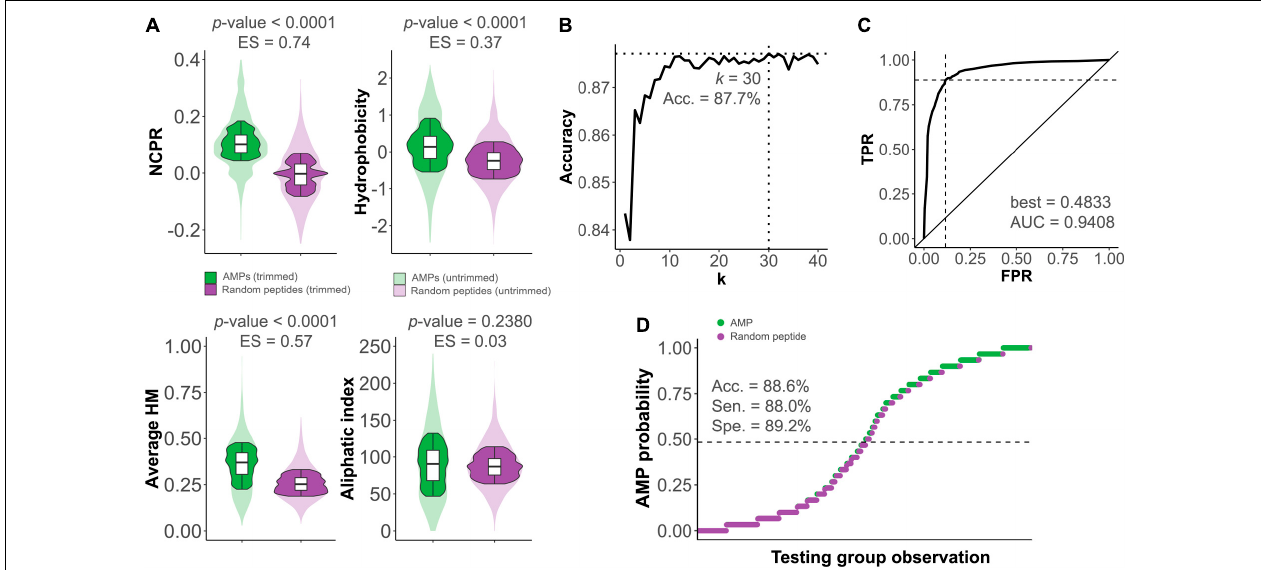
FIGURE 1 | Differences between antimicrobial peptides (AMPs) and non-AMP random peptides. (A) Distributions of different physicochemical properties among AMPs (green) and non-AMPs (purple) within S AMP . ES, effect sizes. (B) Optimization of the k number of neighbors for the k NN predictive algorithm constructed to distinguish between AMPs and non-AMPs. Dashed lines mark the coordinate of the optimum accuracy point. (C) Receiver operating characteristic (ROC) curve of k NN predictive model (TPR, true positive rate; FPR, false positive rate). The ROC-based best AMP probability cut-point for classification (indicated by the dashed lines) and area under the curve (AUC) value are shown. (D) k NN-based prediction of S TEST . The dashed line represents the AMP probability threshold for classification based on the ROC best point. Sensitivity (Sen.), specificity (Spe.), and accuracy (Acc.) are